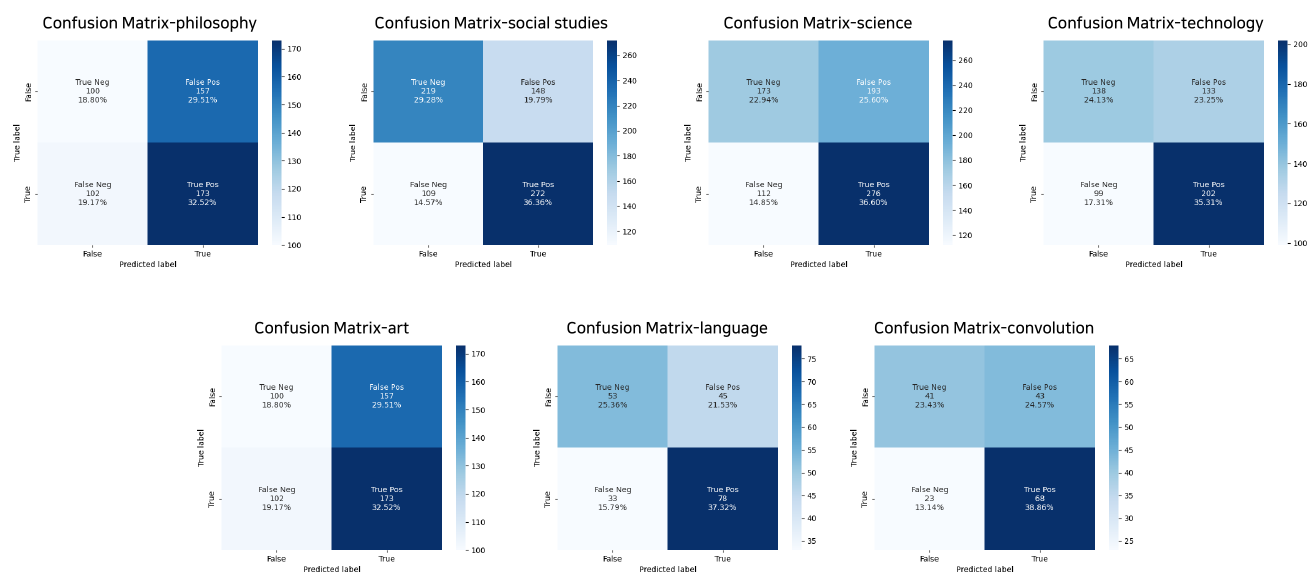
Figure 4. Visualization of augmented language models with confusion matrices of each field. Table 7. Comparison of the best and worst scores in passages. The passage index in the left side column is organized in the order of year-month-domain, and A and B (e.g., 9A, 6B) describe that it was performed twice in